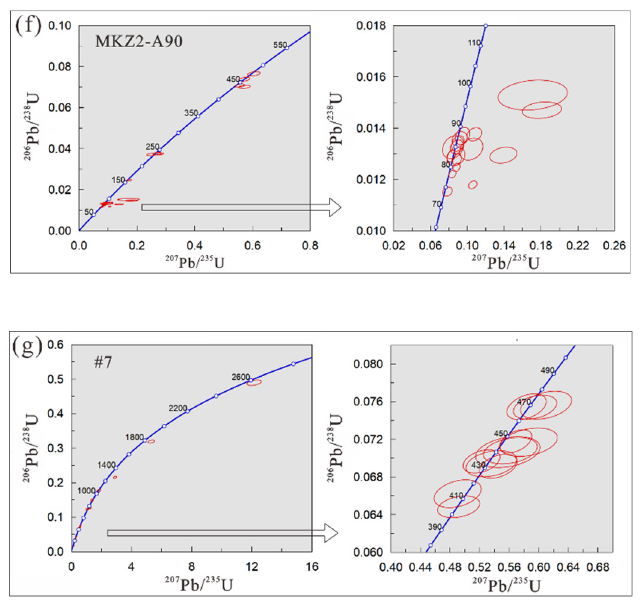
Figure 2. Zircon dating U-Pb concordia diagrams for this study. ( a ) sample #2, ( b ) sample TTL-23 and ( c ) sample #4 are country rock. ( d ) sample #1, ( e ) sample #3, ( f ) sample MKZ2-A90 are fault rock and ( g ) sample #7.